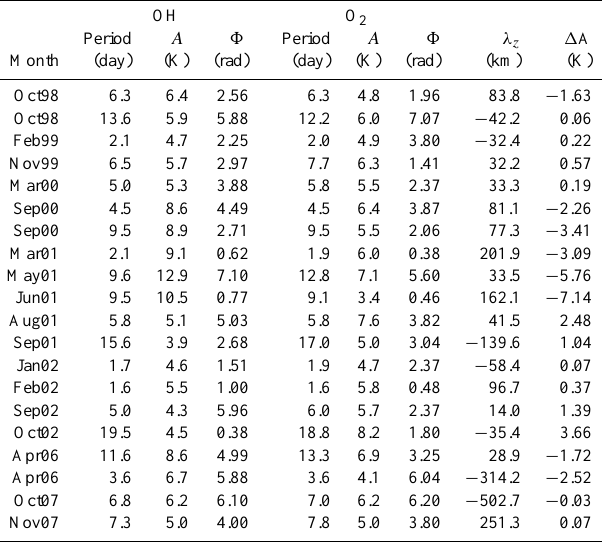
Table 2. Wave parameters detected in temperature